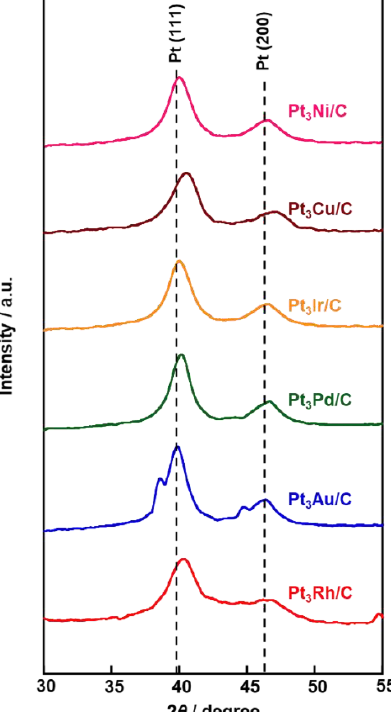
Figure 1. XRD patterns of Pt 3 M/C (M = Rh, Au, Pd, Ir, Cu and Ni) catalysts. Figure 2 shows Pt 4f and Rh 3d, Au 4f, Pd 3d, Ir 4f, Cu 2p or Ni 2p core level spectra for the Pt 3 M/C (M = Rh, Au, Pd, Ir, Cu and Ni) catalysts. For the Pt 3 Rh/C catalyst, Rh 3d spectrum exhibited doublets at 307.4 and 312.3 eV due to metallic Rh (Rh 0 ), which were higher in binding energy than pure Rh 0 (307.0 and 311.7 eV) [34]. For the Pt 3 Au/C catalyst, Au 4f spectrum exhibited doublets at 84.0 and 87.7 eV due to metallic Au (Au 0 ), which almost agree with those of pure Au 0 (84.0 and 87.7 eV) [35]. For the Pt 3 Pd/C catalyst, Pd 3d spectrum exhibited doublets at 335.5 and 340.9 eV due to metallic Pd (Pd 0 ), which were higher in binding energy than pure Pd 0 (335.2 and 340.5 eV) [36]. For the Pt 3 Ir/C catalyst, Ir 4f spectrum exhibited doublets at 61.2 and 64.4 eV due to metallic Ir (Ir 0 ), which were higher in binding energy than pure Ir 0 (60.9 and 63.8 eV) [37]. Additionally, the Ir 4f spec- trum exhibited doublets at 66.1 and 62.9 eV [38] because iridium was oxidized to cations with valences of 4 or more in the air. For the Pt 3 Cu/C catalyst, Cu 2p spectrum exhibited doublets at 932.2 and 952.1 eV due to metallic Cu (Cu 0 ), which were lower in binding energy than pure Cu 0 (932.5 and 952.3 eV) [39]. Additionally, the Cu 2p 3/2 peak at 934.6 eV and Cu 2p 1/2 peak at 954.6 eV due to CuO were observed with the satellite peaks at 941.5, 944.3 and 963.8 eV [39,40]. For the Pt 3 Ni/C catalyst, Ni 2p spectrum exhibited singlet at 852.7 eV due to metallic Ni (Ni 0 ), which was higher in binding energy than pure Ni 0 (852.4 eV) [41]. Also the Ni 2p spectrum exhibited doublets at 857.2 and 874.8 eV due to Ni(OH) 2 with the satellite peaks at 861.2 and 880.2 eV [42,43]. In all Pt 3 M/C catalysts, Pt 4f spectrum exhibited doublets due to metallic Pt (Pt 0 ), which were higher in binding energy than pure Pt 0 (71.1 and 74.4 eV) [44]. These results also support the alloying of Pt with the second metals.